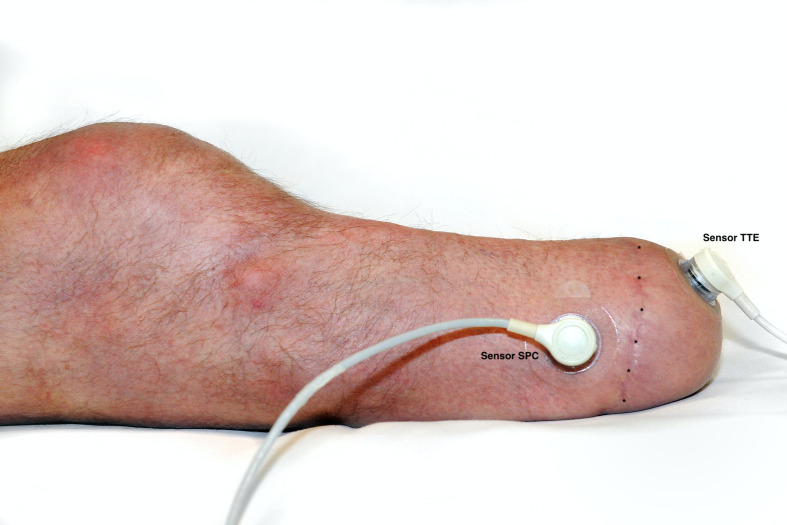
Test setup, lateral view.Same sensor placements as described in Fig 1. The scar (*) depicts the dividing line between the anterior and posterior Burgess flaps and therefore illustrates the choice of sensor placement at the most distal parts of both flaps.